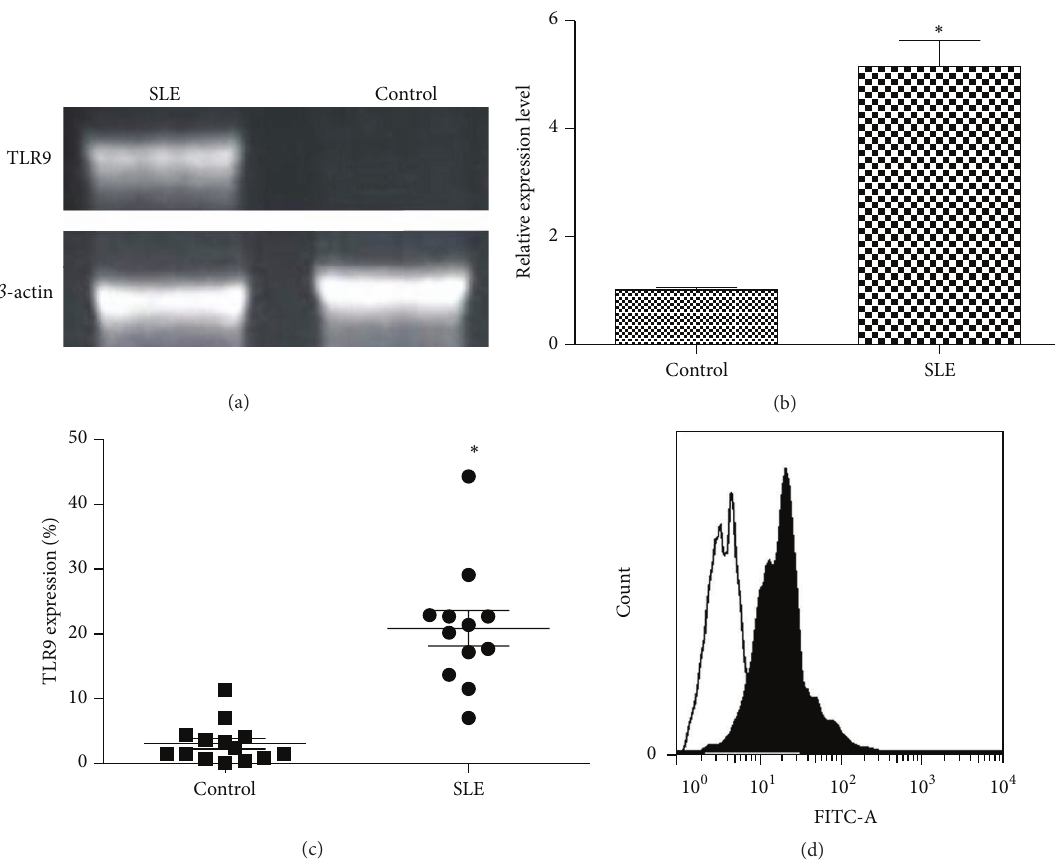
Figure 1: Expression of TLR9 in SLE patients. (a) RT-PCR analysis of TLR9 expression in SLE tissue from patients; (b) mRNA expression of TLR9 in tissues from SLE patients; (c)-(d) flow cytometry analysis of TLR9 expression in B cell; expression of TLR9 in control cells was 4.0% but in SLE cells was 21.2%. ∗ 𝑃 < 0.05 , compared with the